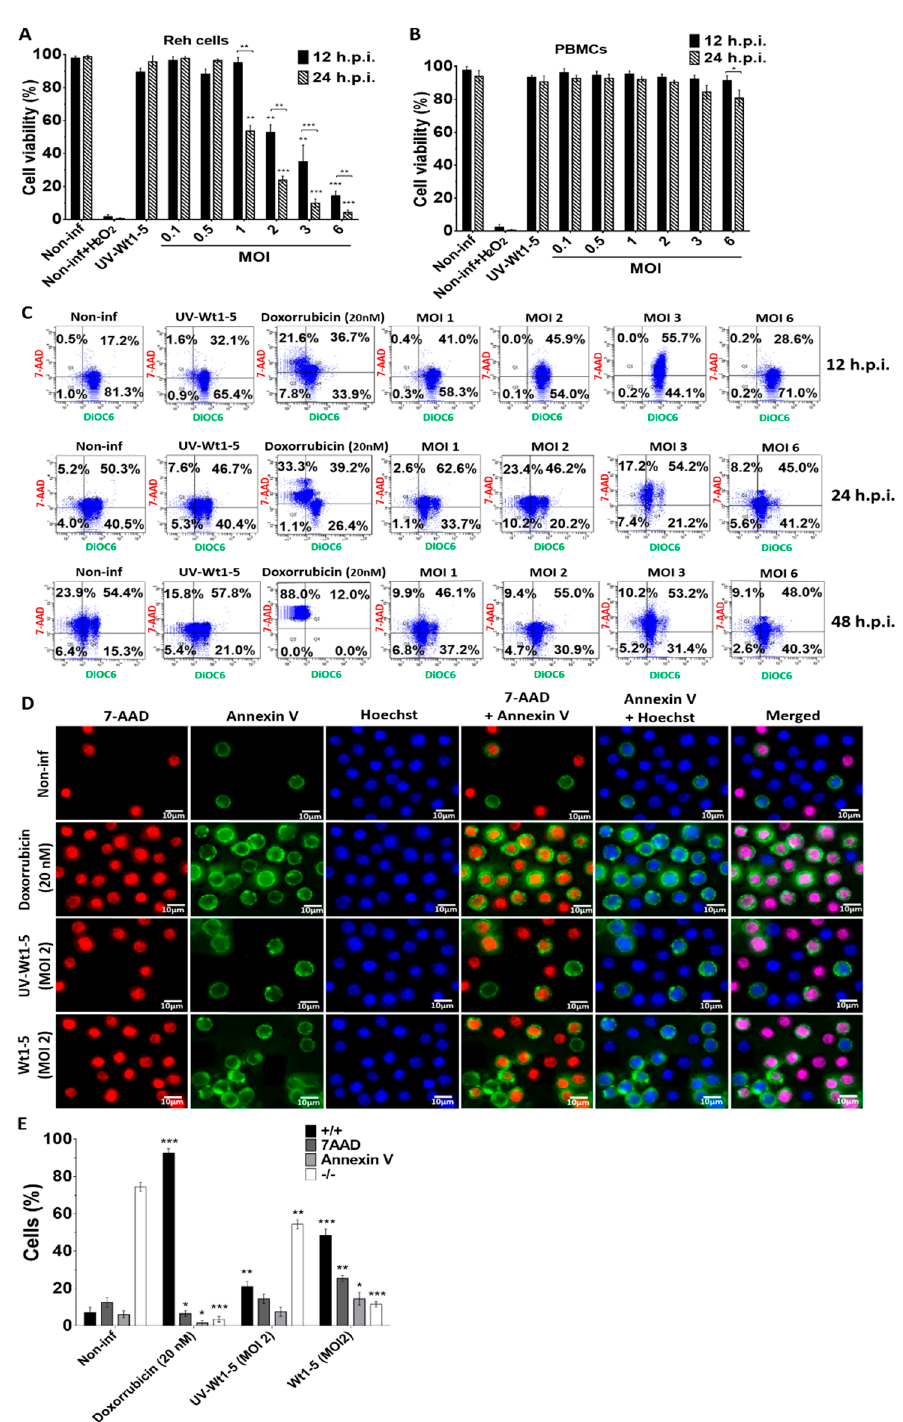
Figure 3. Effect of Wt1-5 infection on redox activity, mitochondrial membrane potential ( ∆Ψ m) and cell membrane permeability. Reh cells at a logarithmic growth phase were infected or not infected with trypsin-activated Wt1-5 (MOI 1 to 6) in RPMI culture medium without FBS. UV-inactivated Wt1-5-infected cells and non-infected cells treated with H 2 O 2 (1 mM) or doxorubicin (20 nm) were used as a control. Cell viability was determined by measuring the cell oxidoreductive activity using the resazurin reduction test at 12 and 24 h.p.i. ( A ) Infected Reh Cells and ( B ) PBMCs are shown. ( C ) Flow